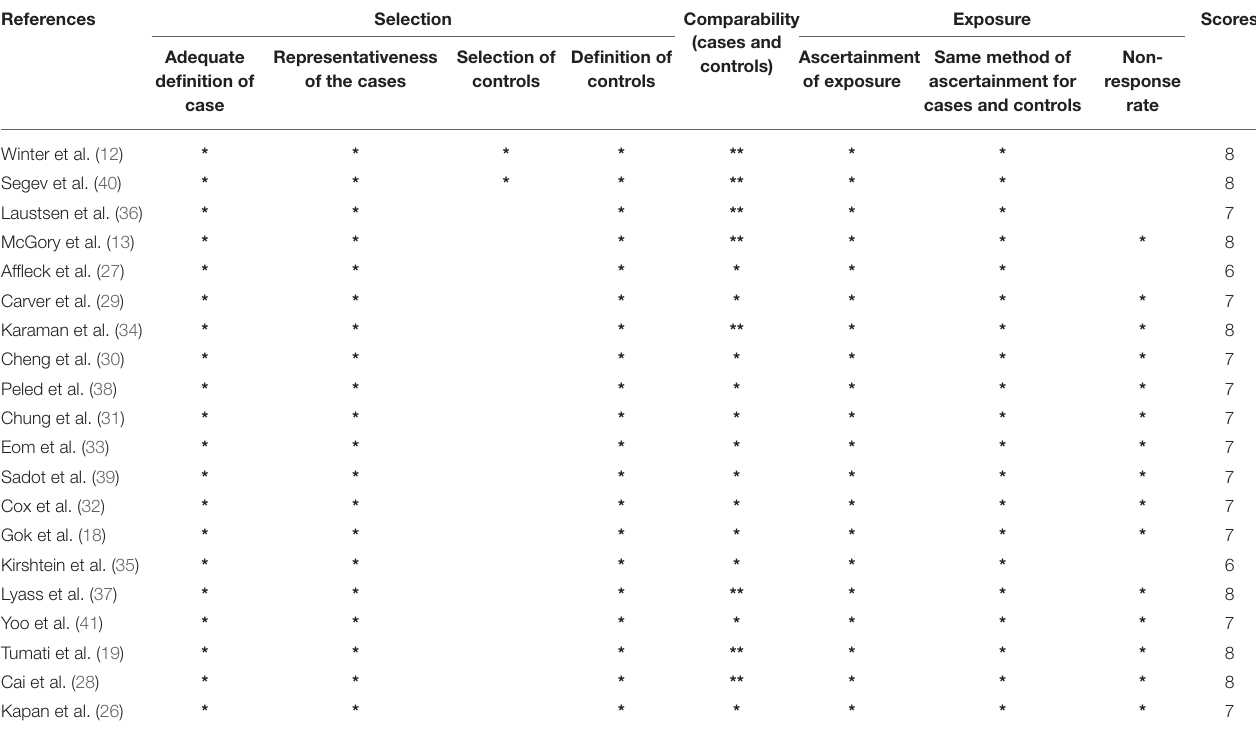
TABLE 4 | The assessment of the risk of bias with the Newcastle Ottawa